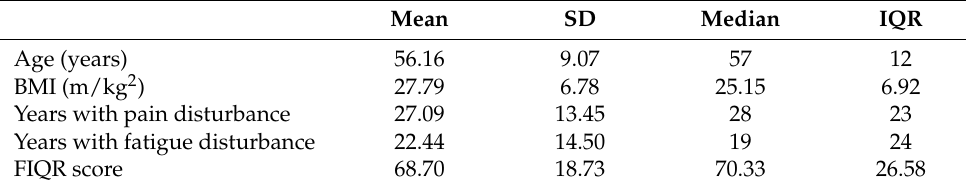
Table 1. Main characteristics of the